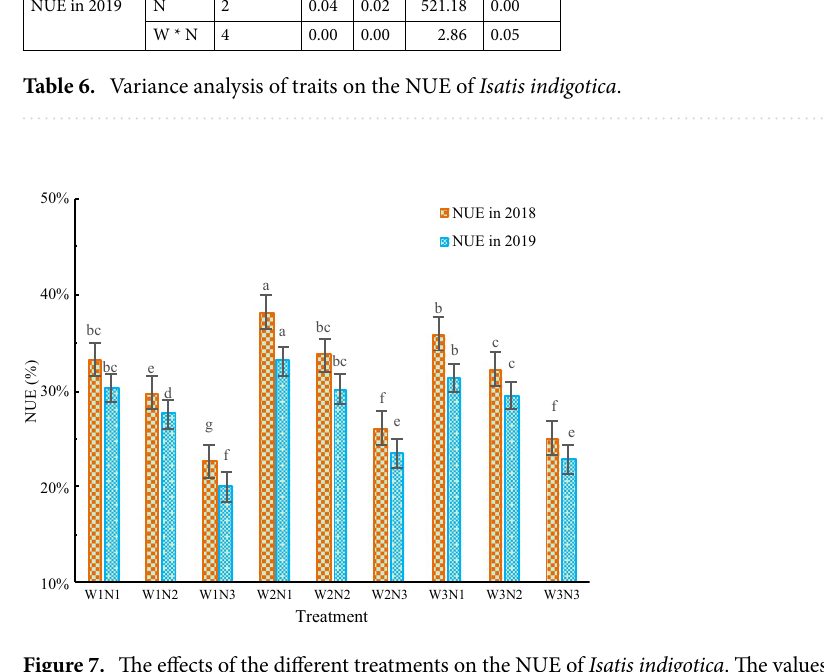
Figure 7. The effects of the different treatments on the NUE of Isatis indigotica . The values shown are the mean ± SD, n = 3. Asterisks indicate a significant difference at the P ≤ 0.05